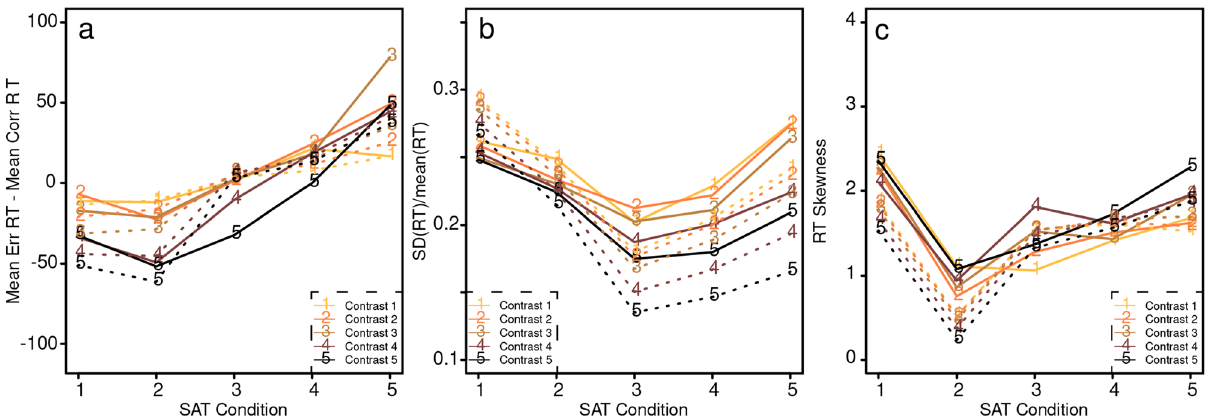
Figure 4. Plots of ( a ) mean error RT minus mean correct RT, ( b ) the SD in RT divided by the mean, and ( c ) RT skewness, each for the 5 speed-accuracy (SAT) conditions. The solid lines are the data and the dotted lines are the theoretical predictions. These are the qualitative “benchmark” analyses that Rafiei and Rahnev claim the diffusion model cannot